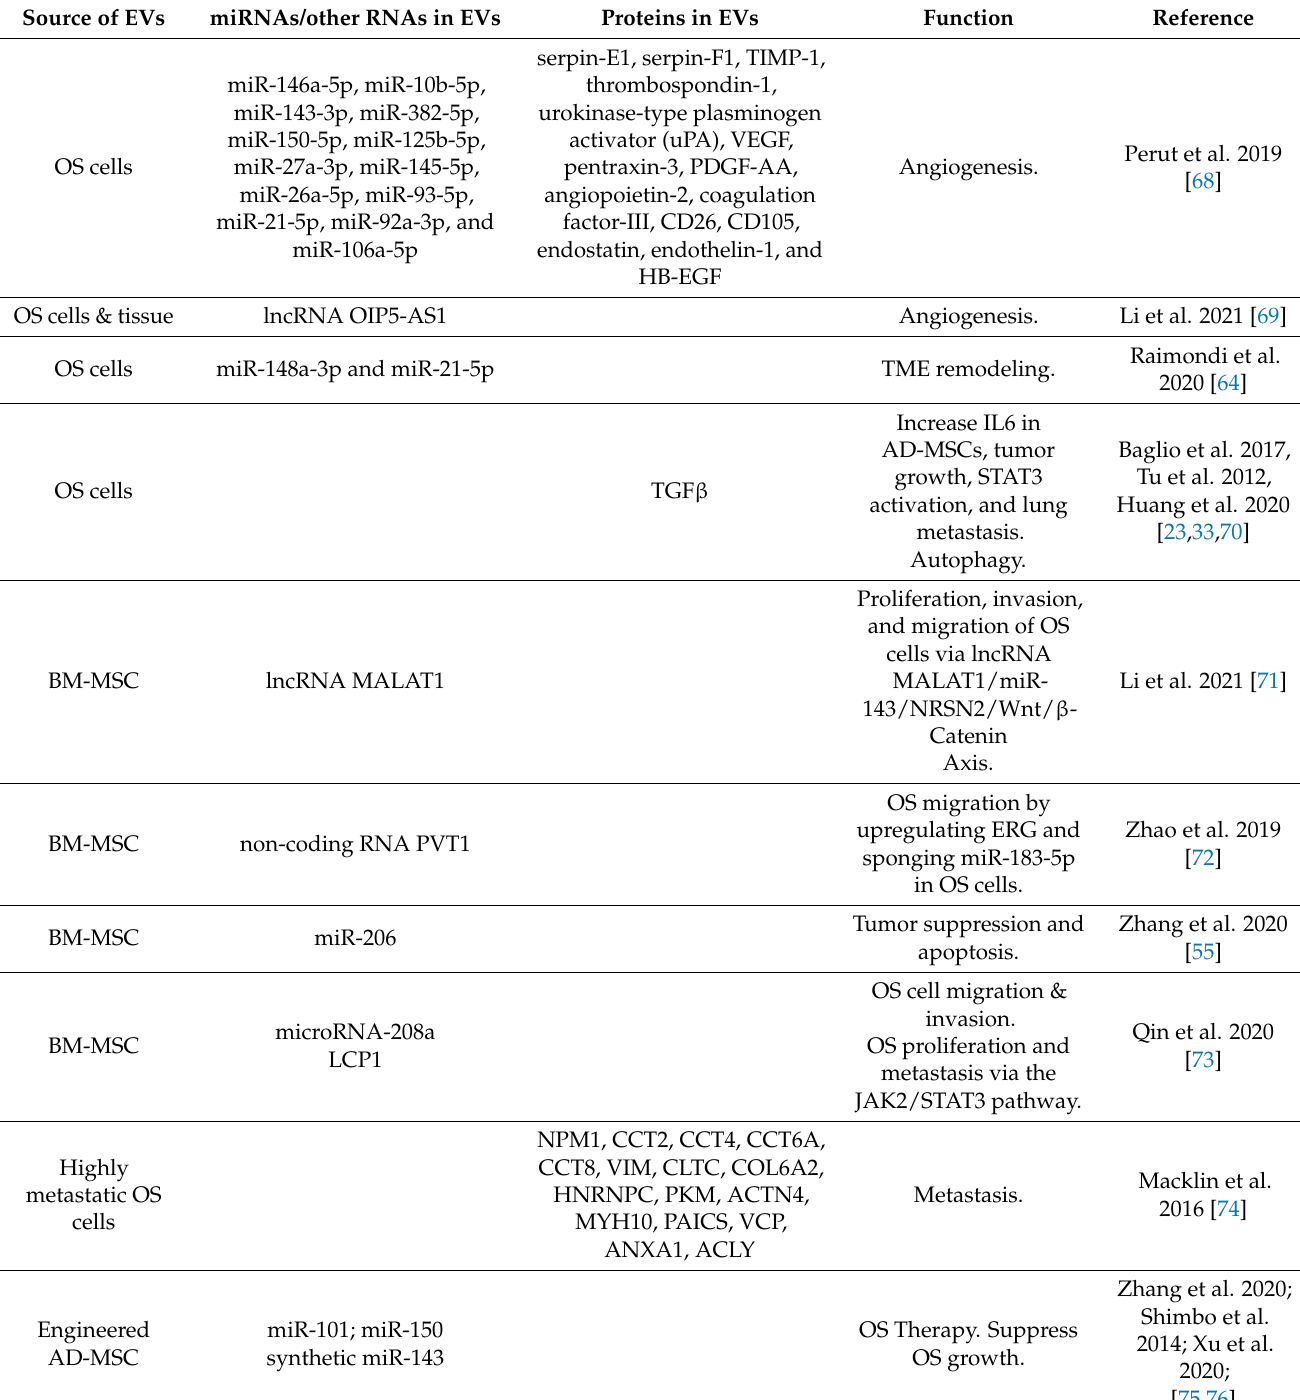
Table 2. Role of microRNA, non-coding RNA, and proteins associated with osteosarcoma (OS) and mesenchymal stem cell (MSC)-derived extracellular vesicles (EVs) in OS